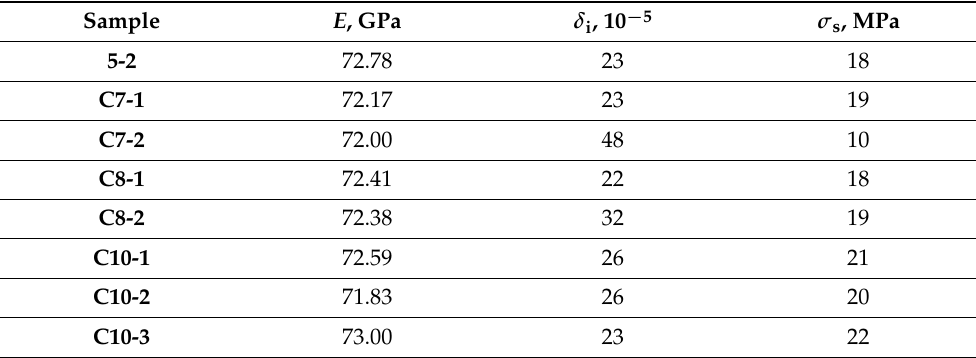
Figure 14. Diagrams of microplastic deformation of aluminum wires after fatigue testing for samples ( a ) C7-1 and C7-2, ( b ) C8-1 and C8-2, and ( c ) C10-1, C10-2, and C10-3. The measurements were made at the room temperature. Table 2. Young’s modulus E , amplitude-independent decrement δ i , and conditional micro-flow strain σ s at inelastic deformation ε d = 1.0 × 10 − 7 .